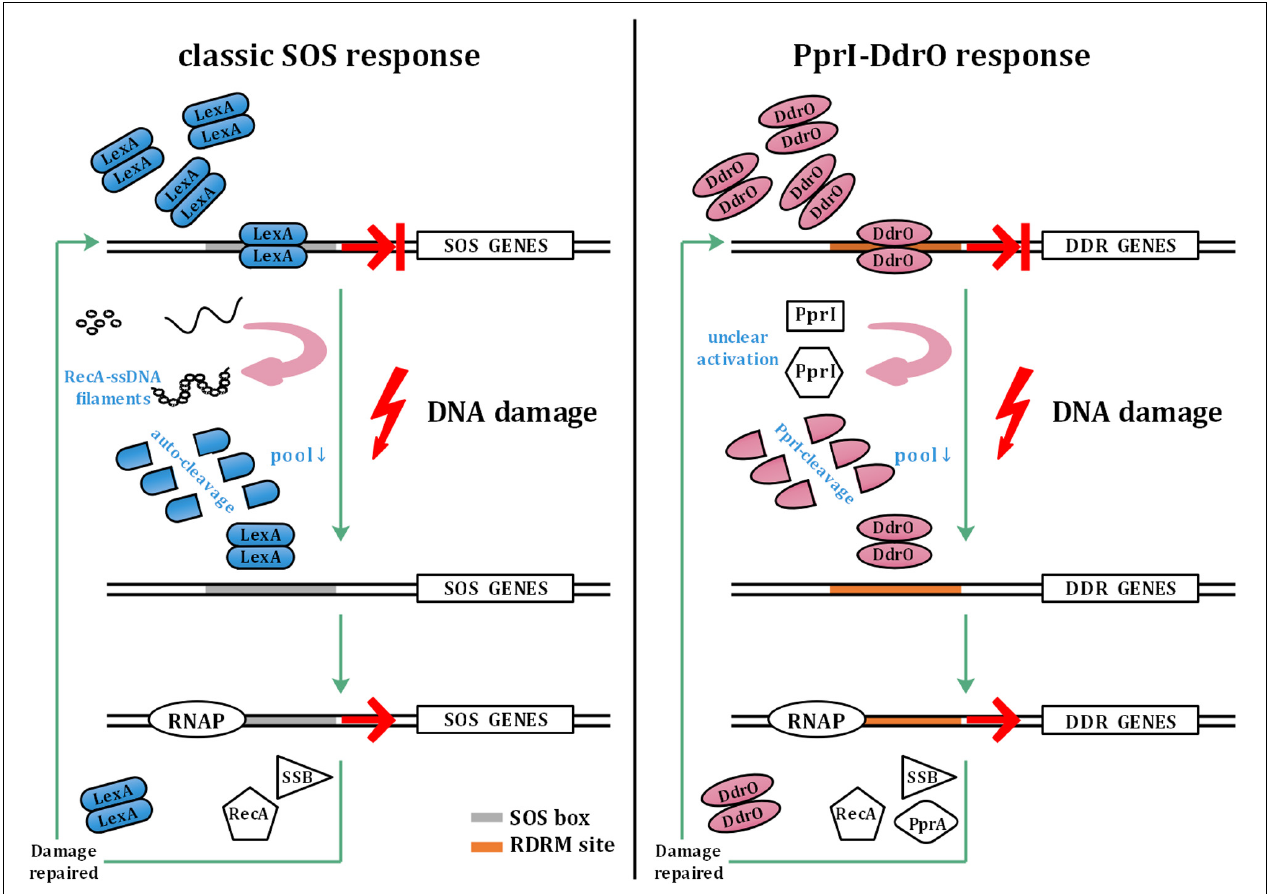
FIGURE 1 | Model of the classic SOS response and PprI–DdrO response. The left panel shows the model of the classic SOS response. LexA inhibits the transcription of SOS genes under normal conditions. Sensing DNA damage, RecA forms filaments with ssDNA and activates autocleavage of LexA. With the decrease in the cellular pool of LexA, SOS box-bound LexA dissociates to initiate the transcription of SOS genes by RNAP (RNA polymerase), which are repressed again by abundant LexA after the damage is repaired. The right panel shows the model of the PprI–DdrO response for comparison. Similar to LexA, DdrO represses the transcription of DDR genes before stresses occur. PprI is activated to efficiently cleave DdrO through an unclear mechanism after sensing DNA damage signals. DDR genes such as recA , ssB , and pprA are upregulated until the damage is